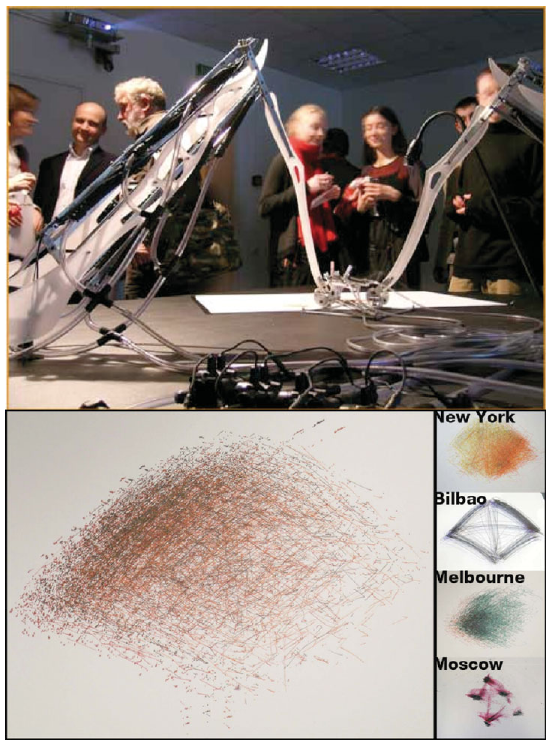
Figure 5. The body of MEART at the Moscow Biennale and drawings . (Top) Metal and plastic arms rested on a 3m × 3m table. Plastic tubes fed pressur- ized air to pneumatic muscles. A digital camera aimed at the paper captured images of the drawing as it progressed. (Bottom right) Development of MEART as reflected in its drawings: New York (July 2003). Video feedback was used for the first time to close the loop, but a “scribble” mode in effect randomized movement and pen placement. Bilbao (April 2004) Removing scribble demon- stratedthearmmovedbetweenfourpointsonly,viaeightmovementdirections corresponding to the possible combinations of muscle activation. Pen place- ment remained random. Melbourne (June 2004) Joint encoders were added to read in arm positions and command movement in a feedforward manner: Muscles were flexed for a duration proportional to the distance to reach the commanded location. Interior positions could be reached as in New York, how- ever,accuracywaslow. Moscow accuracytest(January2005)ABasicSTAMP microcontroller implemented feedback control of arm positions to achieve accurate movement. Outside pens were commanded down when at the target location. The middle pen was commanded down during arm